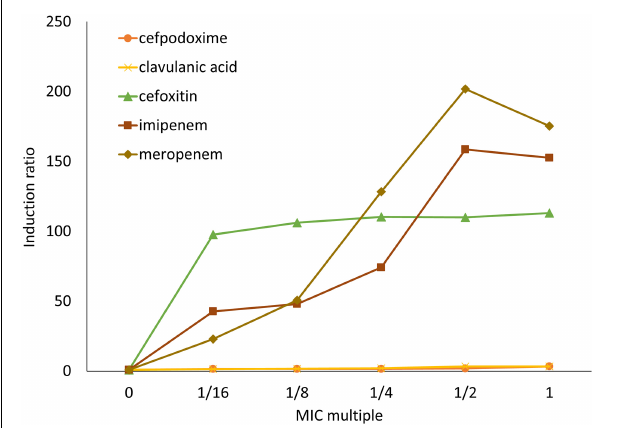
FIGURE 2 | Induction ratios of β -lactamase activity in response to antibiotics on E. ludwigii NR1491. β -lactamase inducers were cefpodoxime